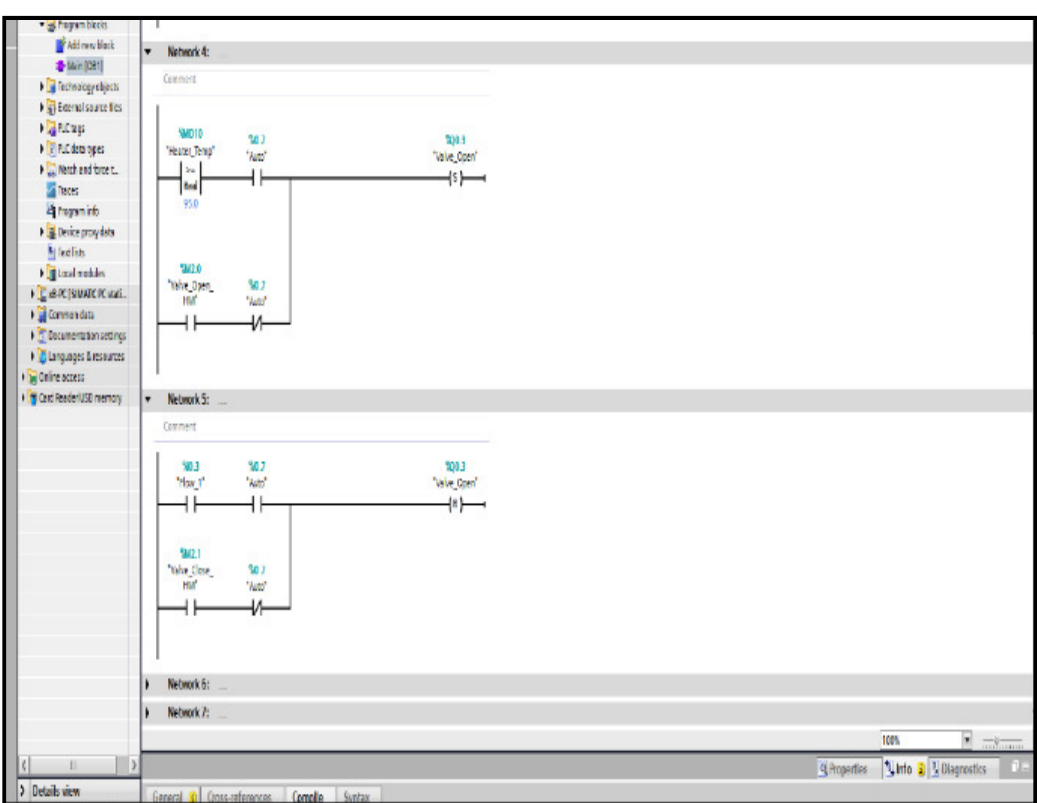
Fig. 5. The ladder logic program.